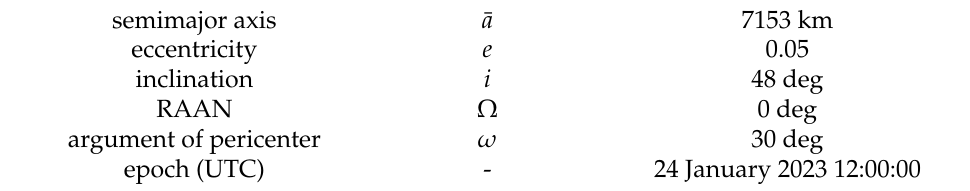
Figure 8. Mid-inclination LEO formation: time behavior of z component. Table 7. Mid-inclination eccentric LEO formation: orbit parameters of chief satellite.